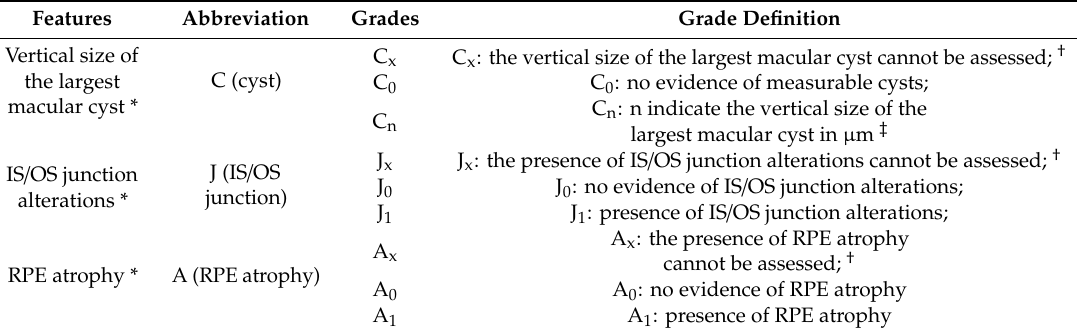
Table 1. CJA Classification of RM.